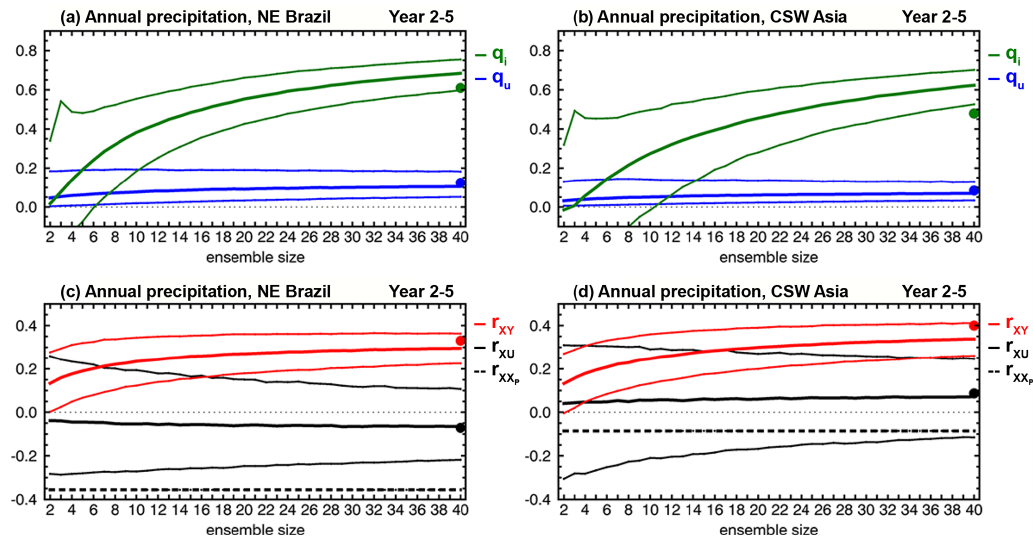
Figure 16. Dependence on ensemble size of (a, b) variance contributions q u = σ 2 green, to (c, d) correlation skill r XY , Eq. (6), in red, of Year 2 ensemble mean precipitation hindcasts, averaged over (a, c) northeastern Brazil ( − 10–5 ◦ N, 50–35 ◦ W) and (b, d) central southwestern Asia (25–55 ◦ N, 40–75 ◦ E). These regions are highlighted in Fig. 15 above. Thick black curves indicate correlation skill r XU of ensemble mean uninitialized simulations. Thick dashed lines indicate correlation skill r XX of the persistence forecast. Thin curves are confidence intervals derived from the 5th and 95th percentiles of bootstrapping distributions generated from 10000 samples by random selection, with replacement, of ensemble members for each indicated ensemble size. Filled dots correspond to the actual 40-member ensemble predictions. Computations of q u , Eq. (A14), and q i , Eq. (A15), are done with m Y = 2 ... 40 members from the hindcast ensemble and, for each m Y , the 40 members from the uninitialized simulations ensemble. The verifying observations used to compute correlation skill are from the GPCP2.3 data set (Appendix B).